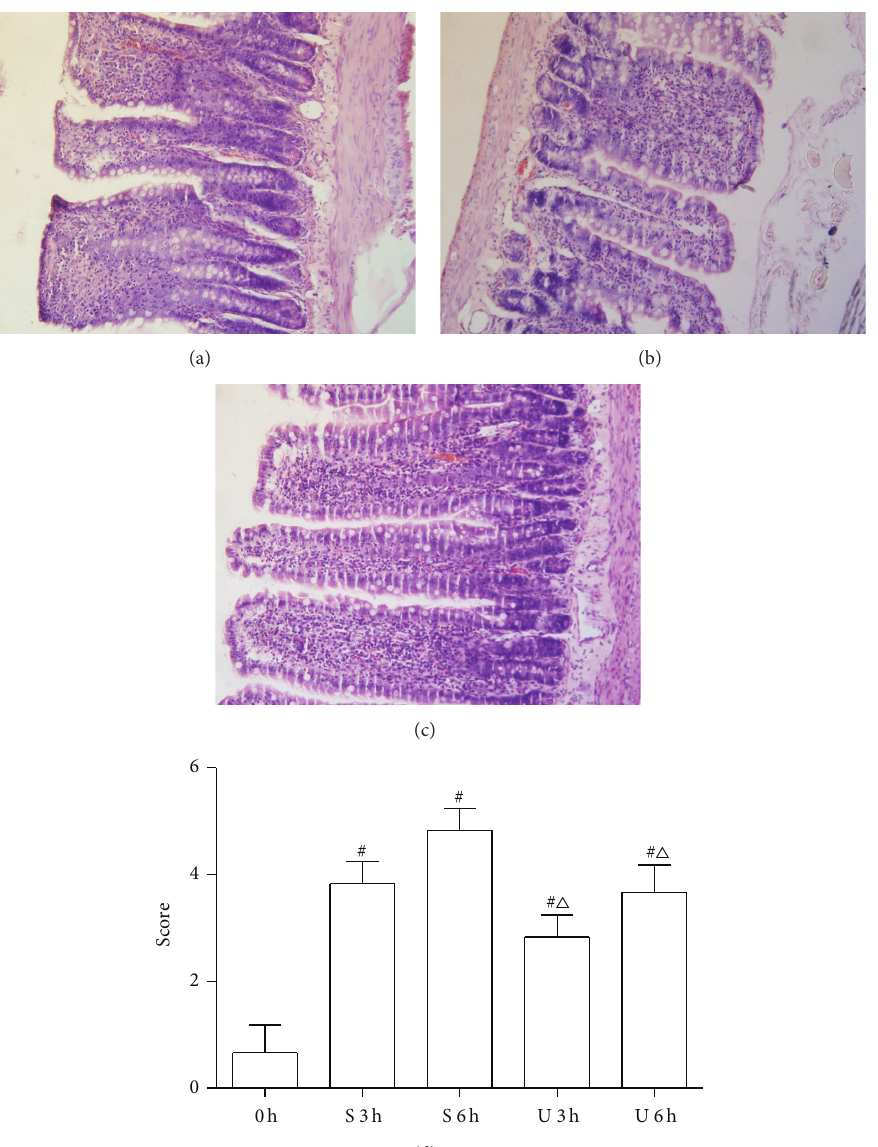
Figure 5: Effects of UTI on the pathological alteration of rat intestinal (light microscope, H&E stain, and original magnification × 100). (a) C group; (b) S group at 6h; (c) U group at 6 h; (d) Chiu’s grade scores: 0 h = C group; S 3 h = S group at 3h; S 6h = S group at 6 h; U 3 h = U group at 3h; U 6 h = U group at 6h. # 𝑃 < 0.05 versus C group and △ 𝑃 < 0.05 versus S group at matched